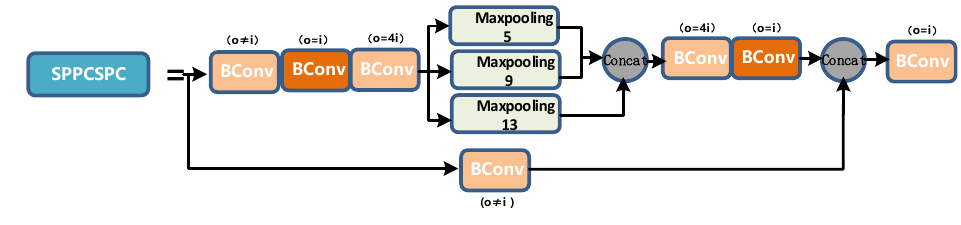
Figure 11. SPPCPC layer diagram.